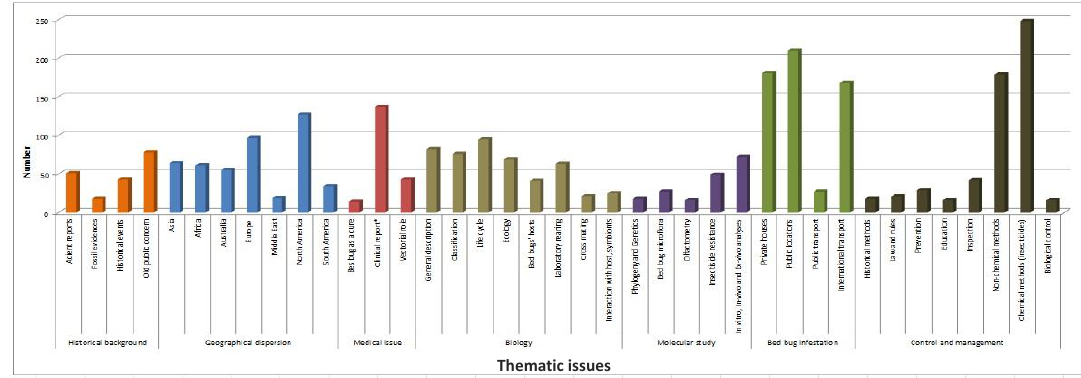
Figure 1. Schematic representation of literature quest strategy used in the present study.